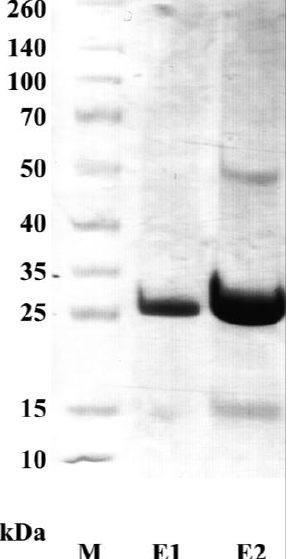
Figure 1. SDS-PAGE analysis of the purified recombinant adiponectin. The full-length adiponectin without LD was expressed as a 6×His fused protein in E. coli and was purified using Ni-NTA based purification. After separating in an SDS-PAGE, the gel was stained with Coomassie Brilliant Blue. E1 and E2: eluate 1 and 2, respectively; M: protein marker.